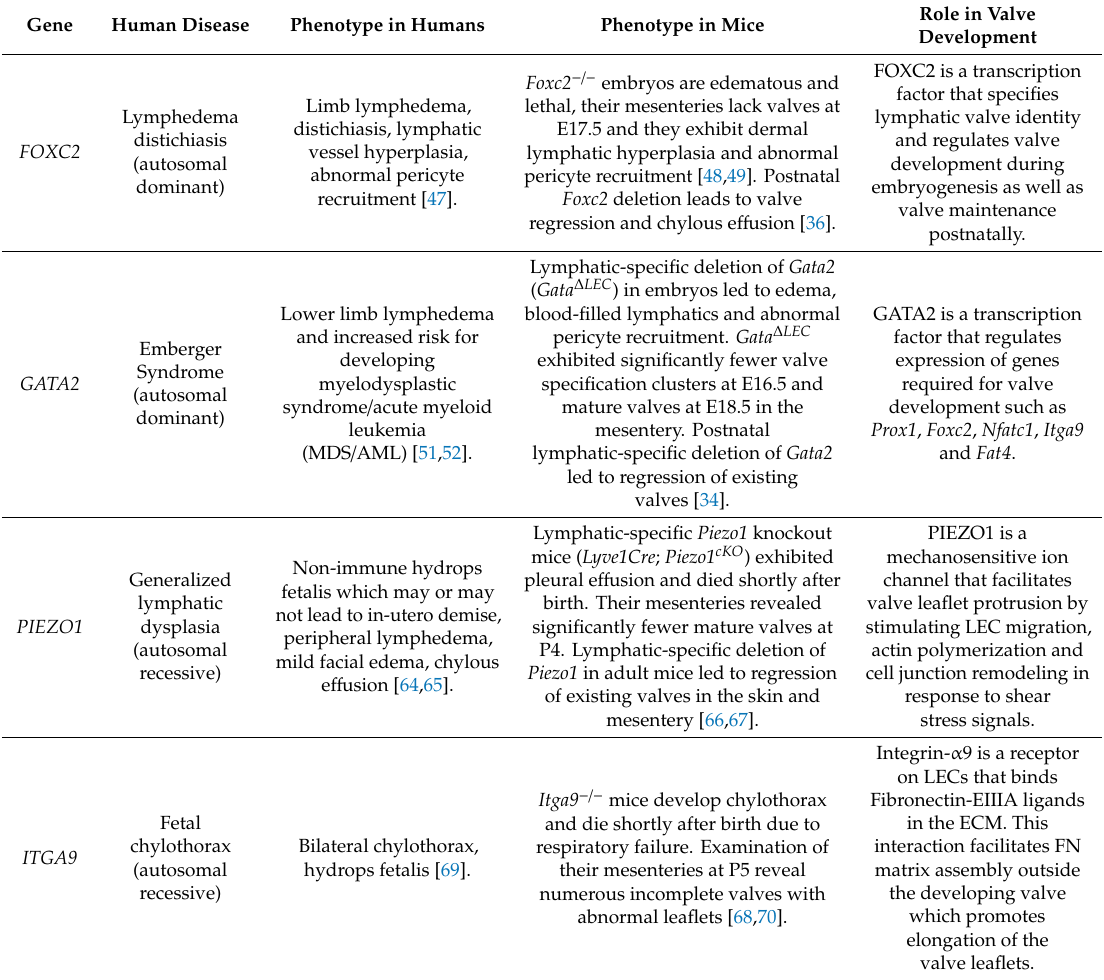
Table 1. Genes mutated in congenital lymphedema that regulate lymphatic valve